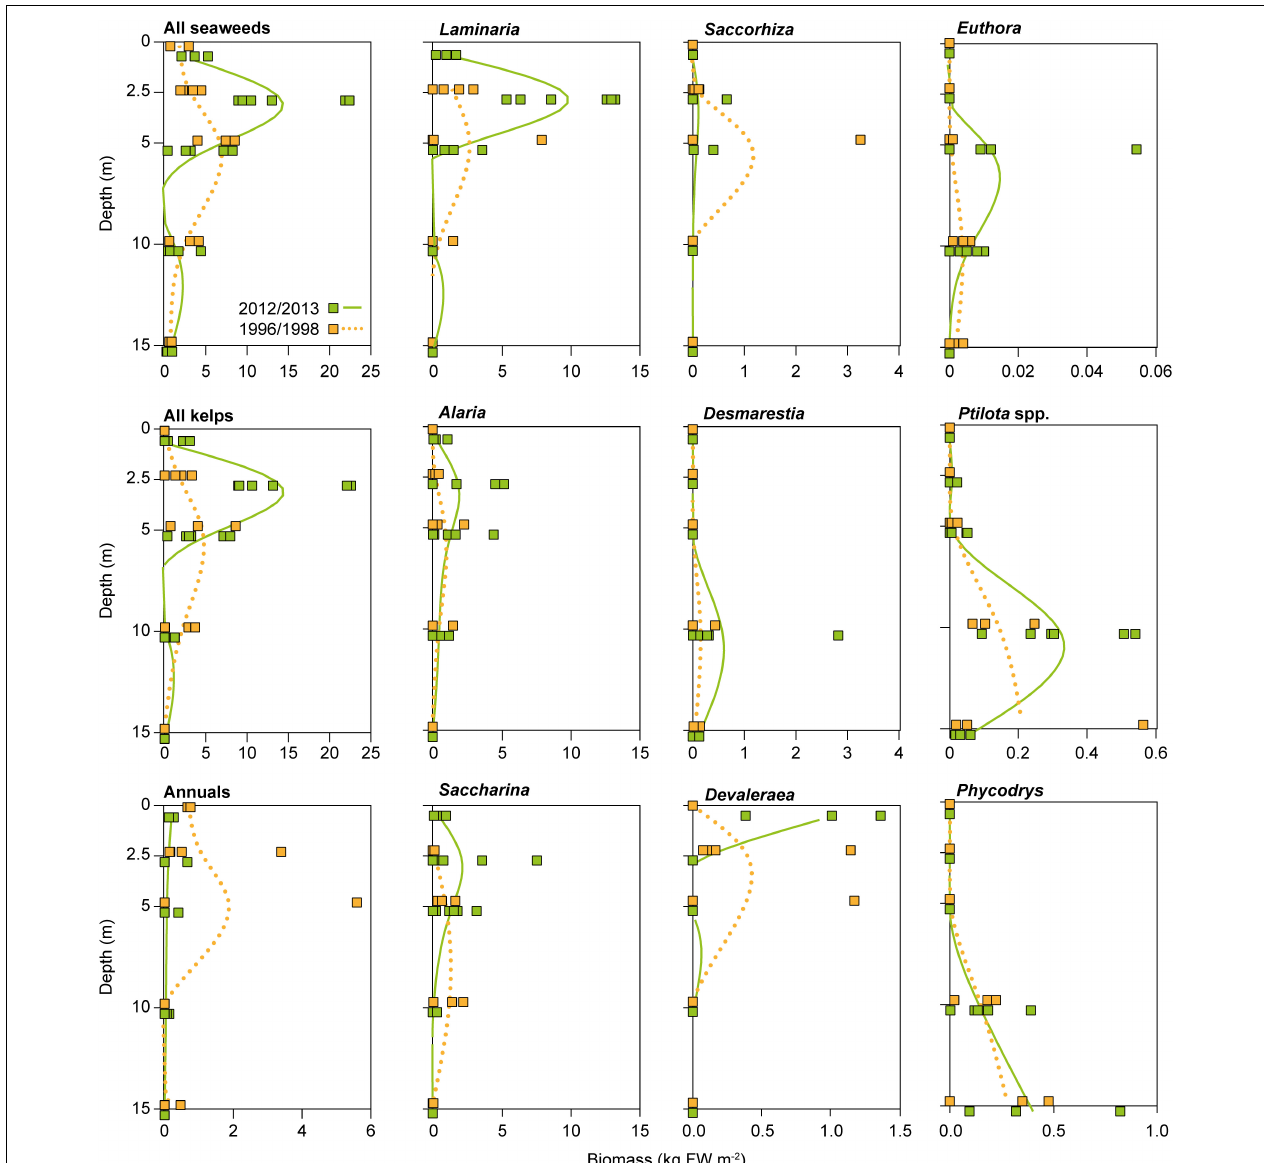
FIGURE 5 | Comparison of fresh weight (FW) m − 2 of biomass-dominant seaweed species or groups along the depth gradient at Hansneset, Kongsfjorden (Svalbard), between 1996/1998 and 2012/2013. Green symbols and lines: 2012/2013 data. Orange symbols and dotted lines: 1996/1998 data. Regression curves are cubic-fit splines visualizing the general trend in biomass distribution. 2012/2013: 0 and 15 m ( n = 3), 2.5, 5, and 10 m ( n = 6); 1996/1998: 0 m ( n = 2), 2.5 m ( n = 4; original 1.5 and 2.5 m data combined), 5, 10, and 15 m ( n = 3). Only genus names are provided. Desmarestia refers to D. aculeata . Euthora is synonymous to Callophyllis in Hop et al. (2012). Adapted from Bartsch et al. (2016) with